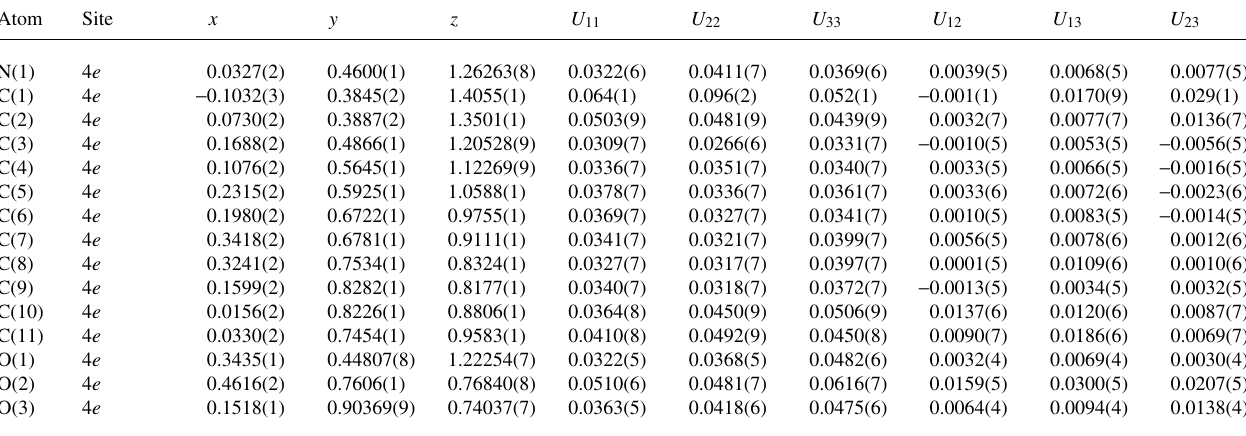
Table 3. Atomic coordinates and displacement parameters (in Å 2 )